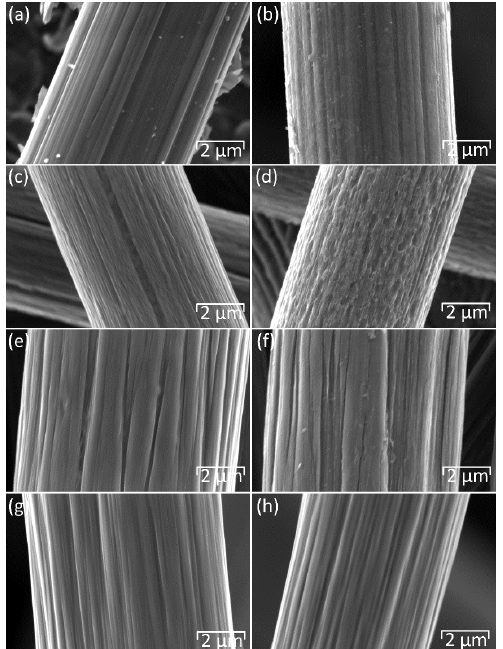
Figure 2. SEM images of materials before ( a , c , e , g ) and after ( b , d , f , h ) thermal oxidation at 550 °C for 5 h: ( a , b ) 22AA, ( c , d ) MGL370, ( e , f ) carbon cloth, ( g , h ) GF. Magnification 20,000Accelerating voltage 5 kV. Working distance 14 mm.